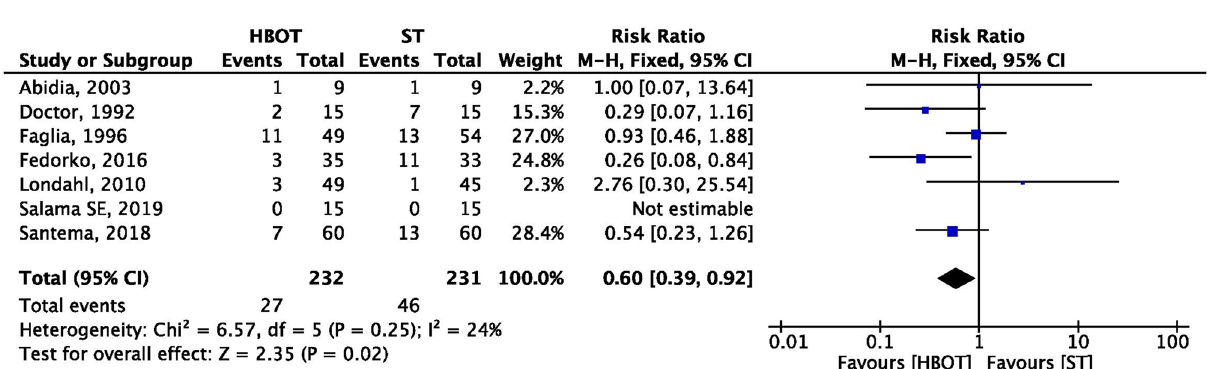
Figure 4. Forest plot of comparison: HBOT versus ST, Outcome: Complete Healed Ulcer.